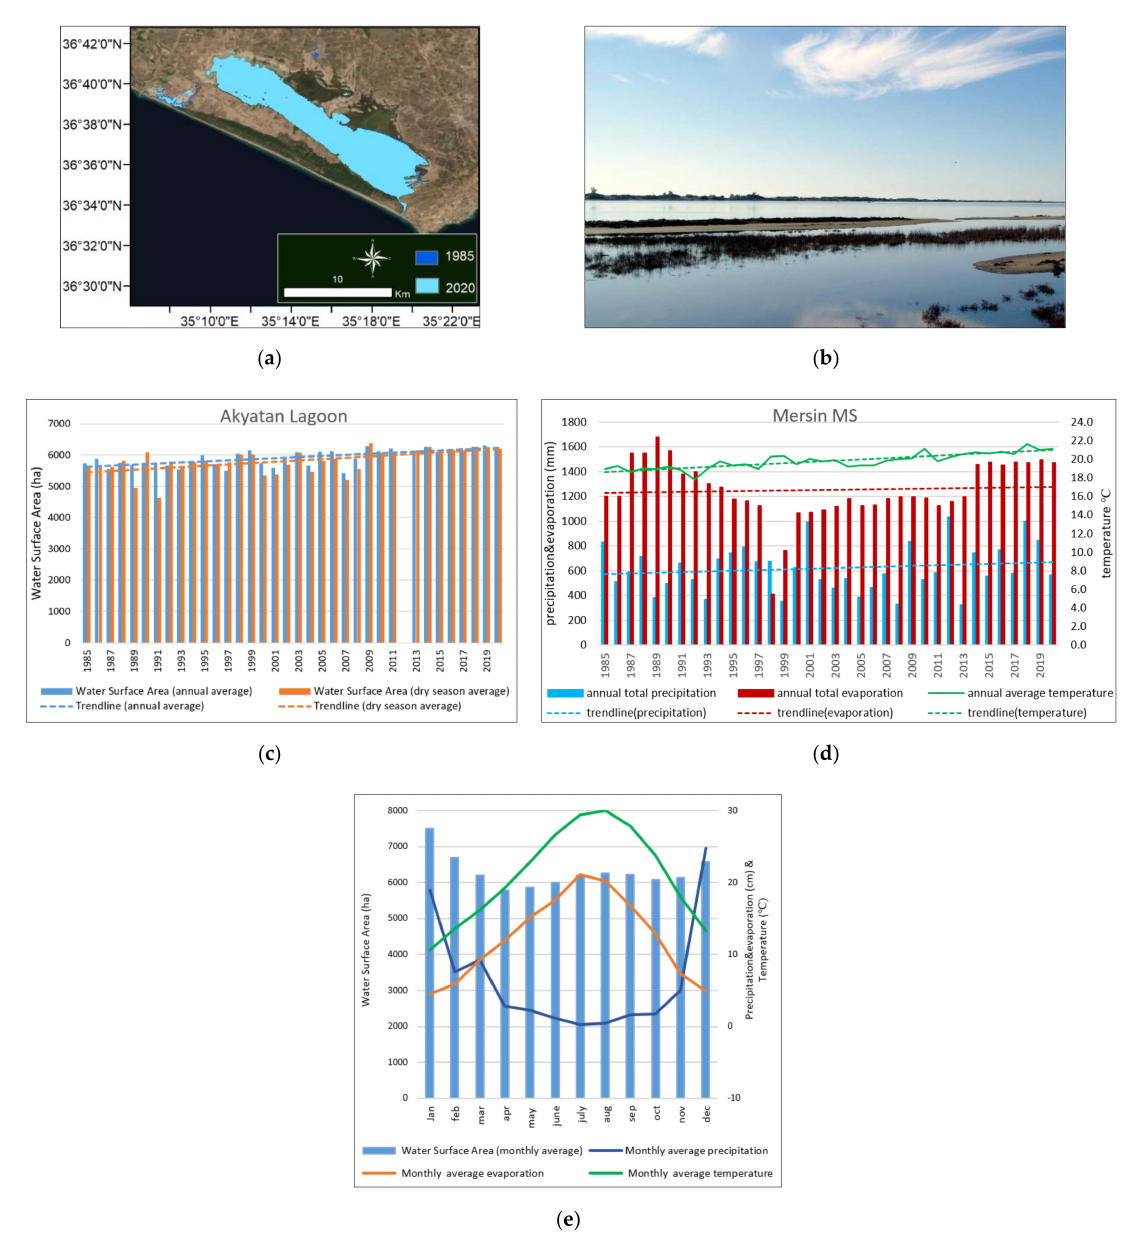
Figure 5. Akyatan Lagoon: ( a ) Location and 1985 and 2020 Annual Average Water Surface Areas (NDWI > 0); ( b ) View of Akyatan Lagoon [47]; ( c )1985–2020 Period, Water Surface Areas (Annual Averages and Dry Season Averages); ( d ) Mersin Meteorological Station Data (Annual Total Precip- itation, Total Evaporation, and Average Air Temperature); ( e ) 2016–2020, Monthly Average Water Surface Areas, Precipitation, Evaporation and